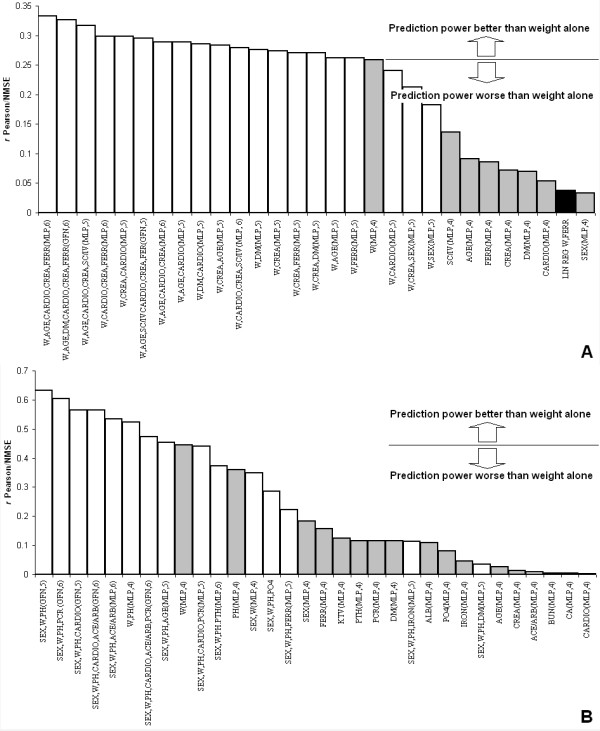
Performance ability of individual and combined variables in predicting the epoetin dose. Performance ability of individual and combined variables in predicting the mean epoetin beta dose required for an individual patient to reach the haemoglobin target of 11.5 g/dL using ANNs and linear regressions. The performance ability is expressed by the r/NMSE (the higher the value the better the performance). The network structure (either Multilayer Perceptron (MLP) or Generalized Feedforward Network (GFN) and number of processing elements in the hidden layer) is specified in the label of the ANN used for the prediction. Panel A: data from the AIMSEOC (training, cross-validation, testing and validation data pool: 170, 30, 122 and 110 patients respectively); the column of the linear regression is in black; individual variables are highlighted in grey. Panel B: data from the EOC alone (training, testing and validation data pool: 60, 10 and 22 patients respectively).